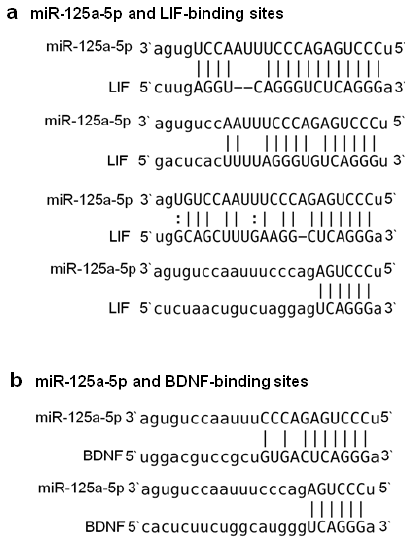
Figure 8. miR-125a has binding sites for 3’UTR of mRNA for BDNF and LIF.